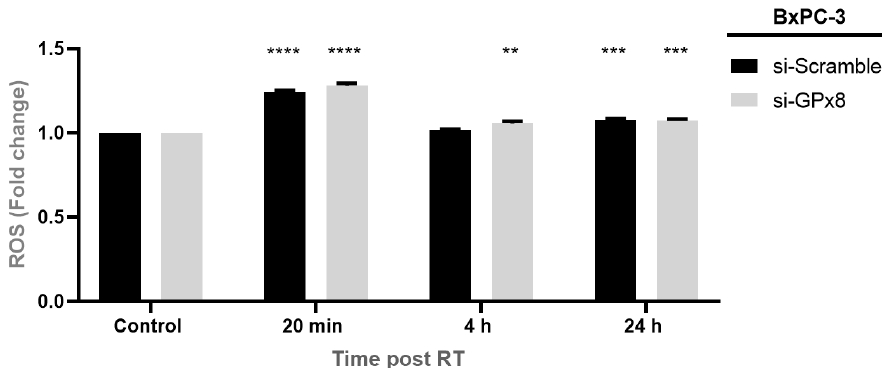
Figure 11. Silencing GPx8 alters ROS levels post-radiation treatment. ROS levels were assessed 20 min, 4 h, and 24 h post-radiation treatment (RT) and compared to its untreated control (0 Gy). Radiation treatment resulted in a significant increase in ROS levels at 20 min (**** p < 0.0001), 4 h (** p = 0.0073), and 24 h (*** p = 0.0004) post-RT. Levels of ROS returned to baseline by 4 h post-RT in the scrambled control, but remained elevated in cells where GPx8 had been silenced. Data are expressed as the mean ± SEM ( n = 3). Two-way ANOVA with Tukey’s post-hoc test was adopted for